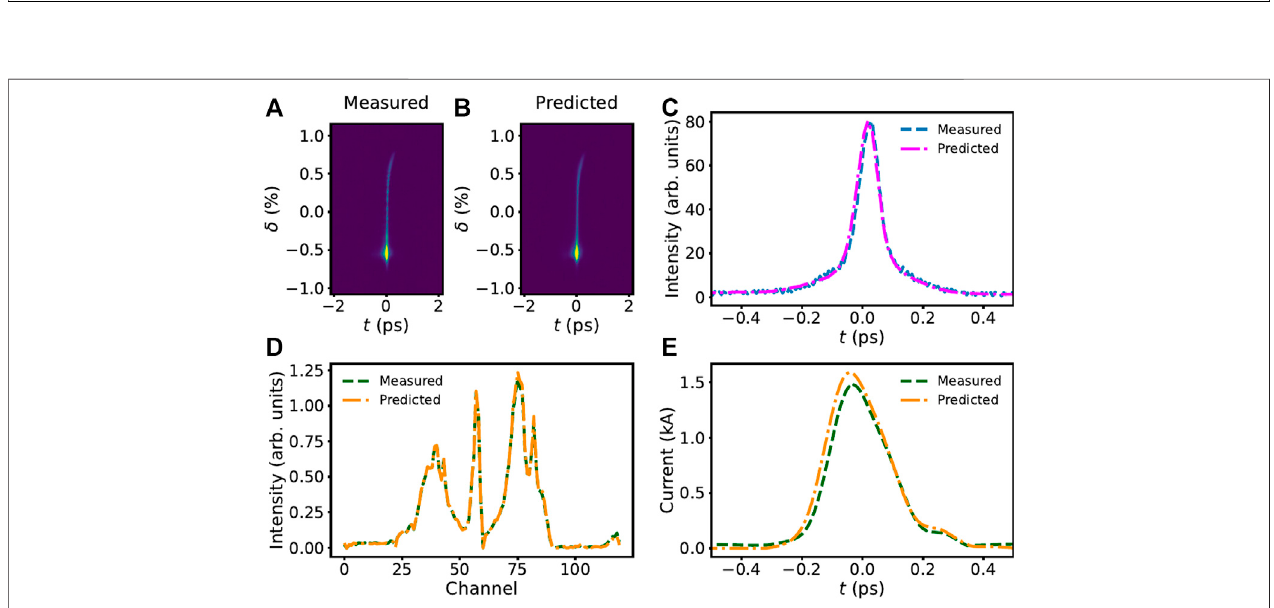
FIGURE 8 | An example result for the scan shown in Figure 7 . (A) Measured LPS image. (B) Predicted LPS image. (C) Comparison of the current pro fi les calculated from the measured and predicted LPS images. Because the LPS depends on the streaking direction of the TDS in a non-trivial way due to transverse- longitudinalcorrelations,thecurrentpro fi lehereissimplytheprojectionoftheLPSimageintheverticaldirection. (D) Comparisonofthemeasuredandpredictedspectra from the low-frequency grating set of the CRISP spectrometer. (E) Comparison of the current pro fi les reconstructed from the measured and predicted spectra.